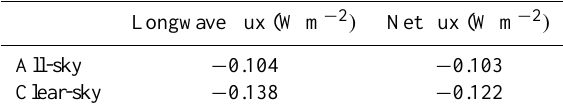
Table 1. Annual average difference in the longwave and net (long- wave plus shortwave) fluxes at the tropical tropopause (20 ◦ S– 20 ◦ N) for two CAM-Chem simulations with and without VSL halogen